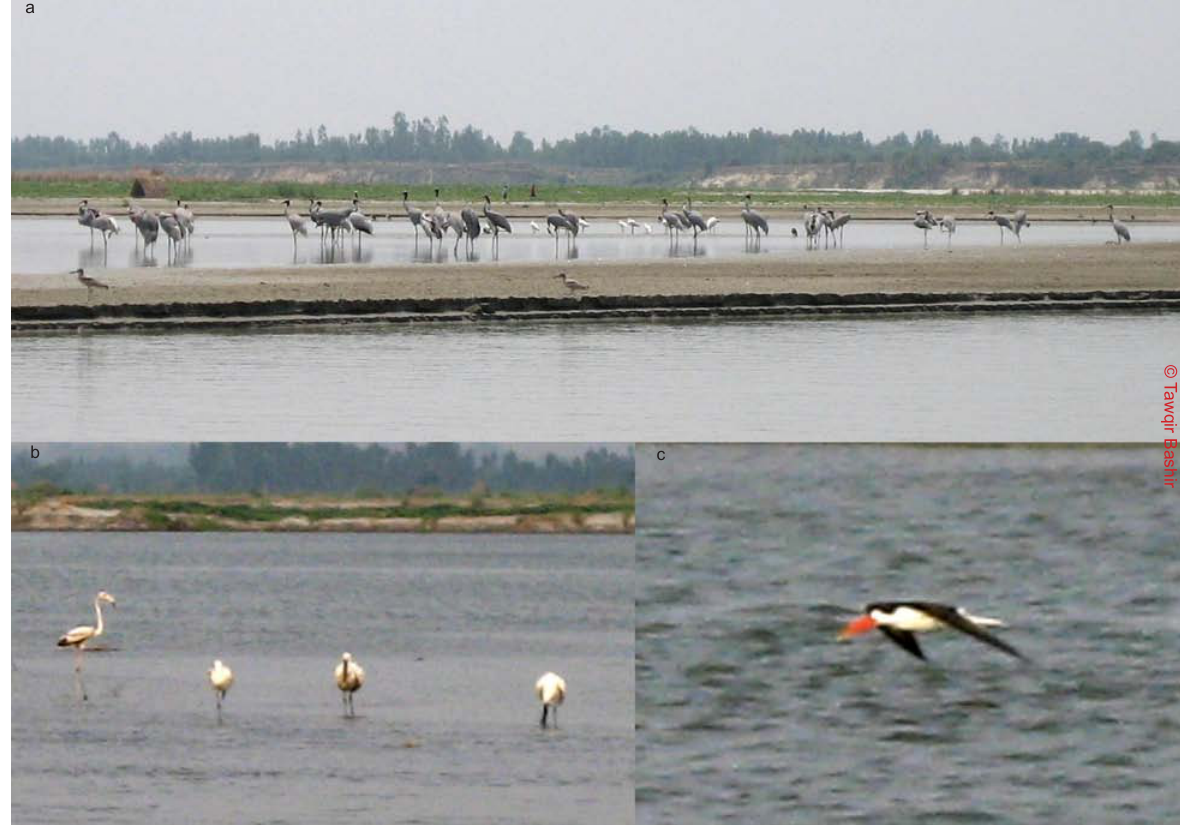
Image 2. (a) Sarus Cranes; (b) Greater Flamingo and Eurasian Spoon Bill; (c) Indian